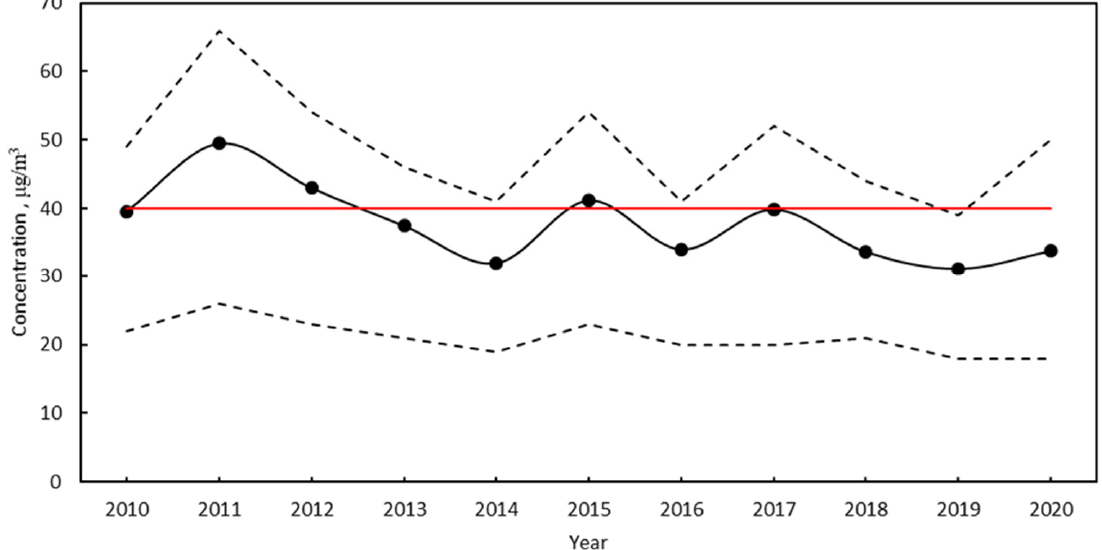
Figure 3. The 2010–2020 PM10 annual averages in the Milan stations measured by ARPA Lombardia (black solid line), 25th and 75th percentile of the annual averages (black dashed line), and PM10 annual law limit of 40 µ g/m 3 according to Lgs. 155/2010 (red solid line).